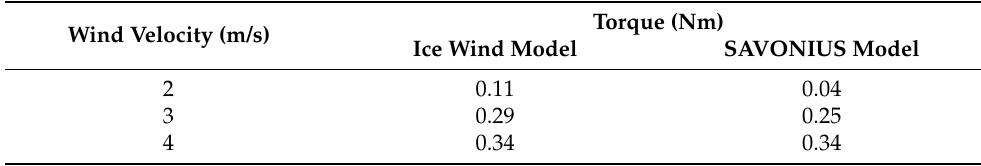
Table 5. Torque values for the experimental rotor models